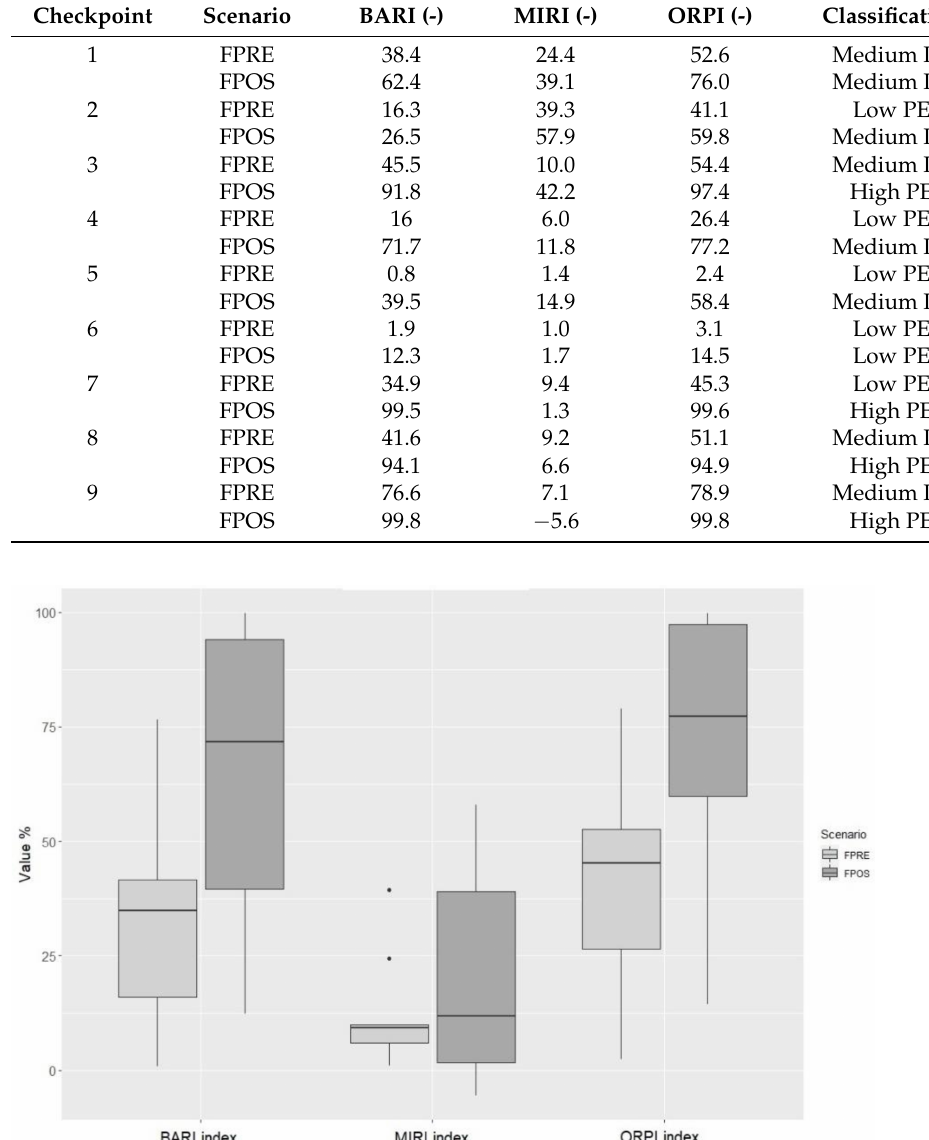
Figure 7. Boxplot of the values for the three indices BARI, MIRI, and ORPI in the scenarios FPRE, in light grey, and FPOS, in dark grey. The first index quantifies the barrier effect played by the protection forest, the second index is related to the maximum intensity reduction, and the last one is related to the overall protective